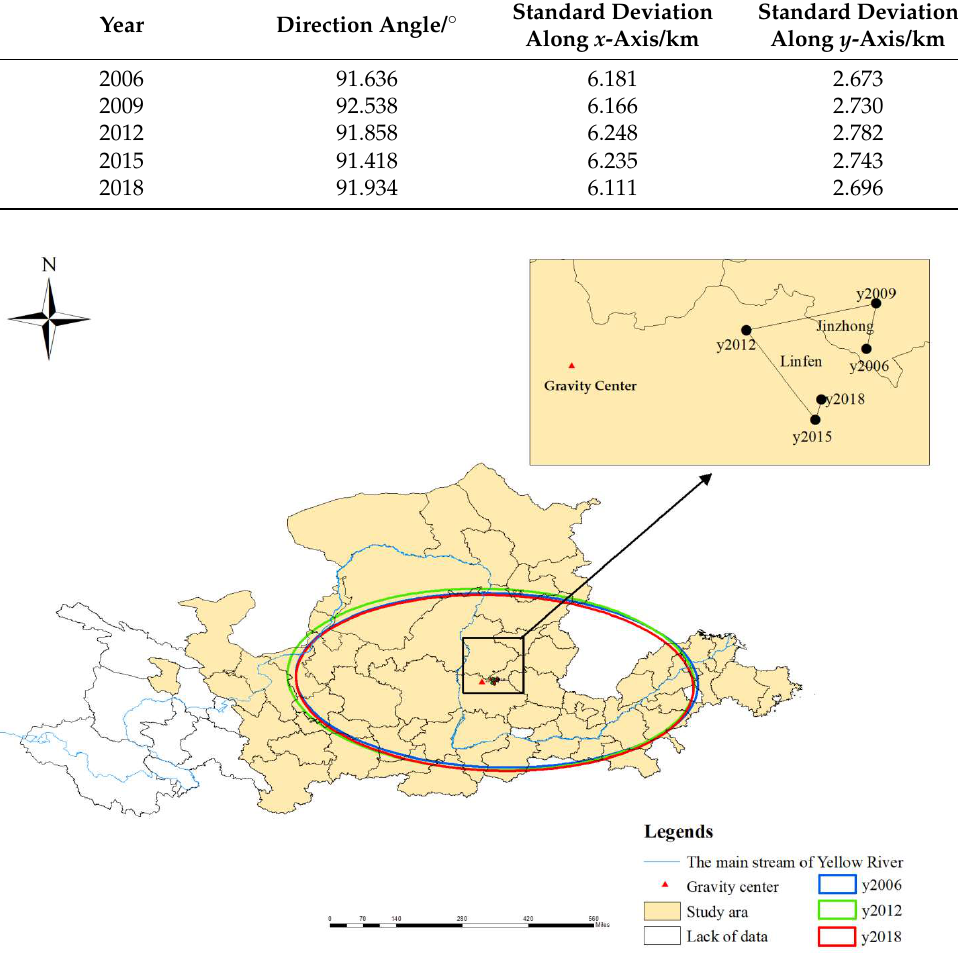
Figure 2. Shifting routes of energy eco-efficiency gravity centers and SDEs in the